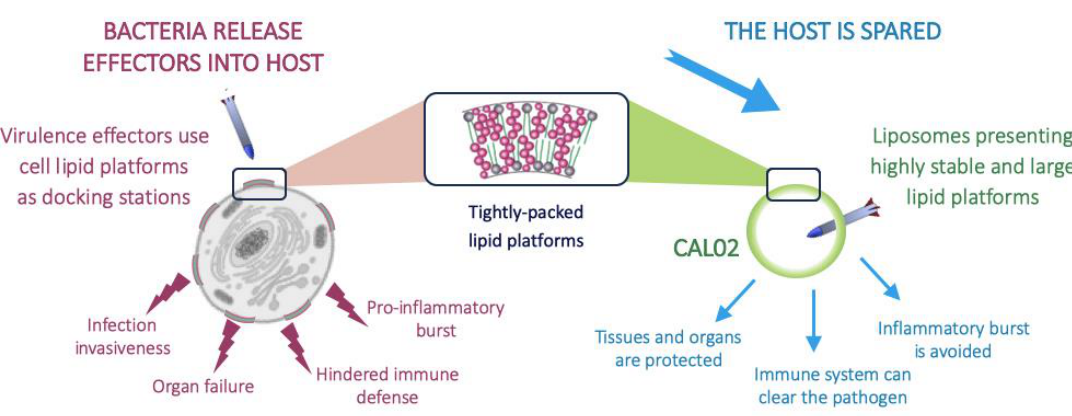
Figure 1. Schematic illustration of CAL02’s mechanism of action. The vast majority of virulence effectors dock on cellular lipid platforms to attack the host cells and tissues. CAL02 mimics these platforms in a highly stable manner. Virulence effectors bind to CAL02 with a higher affinity than to cells. CAL02 thus acts as a high-affinity trap.